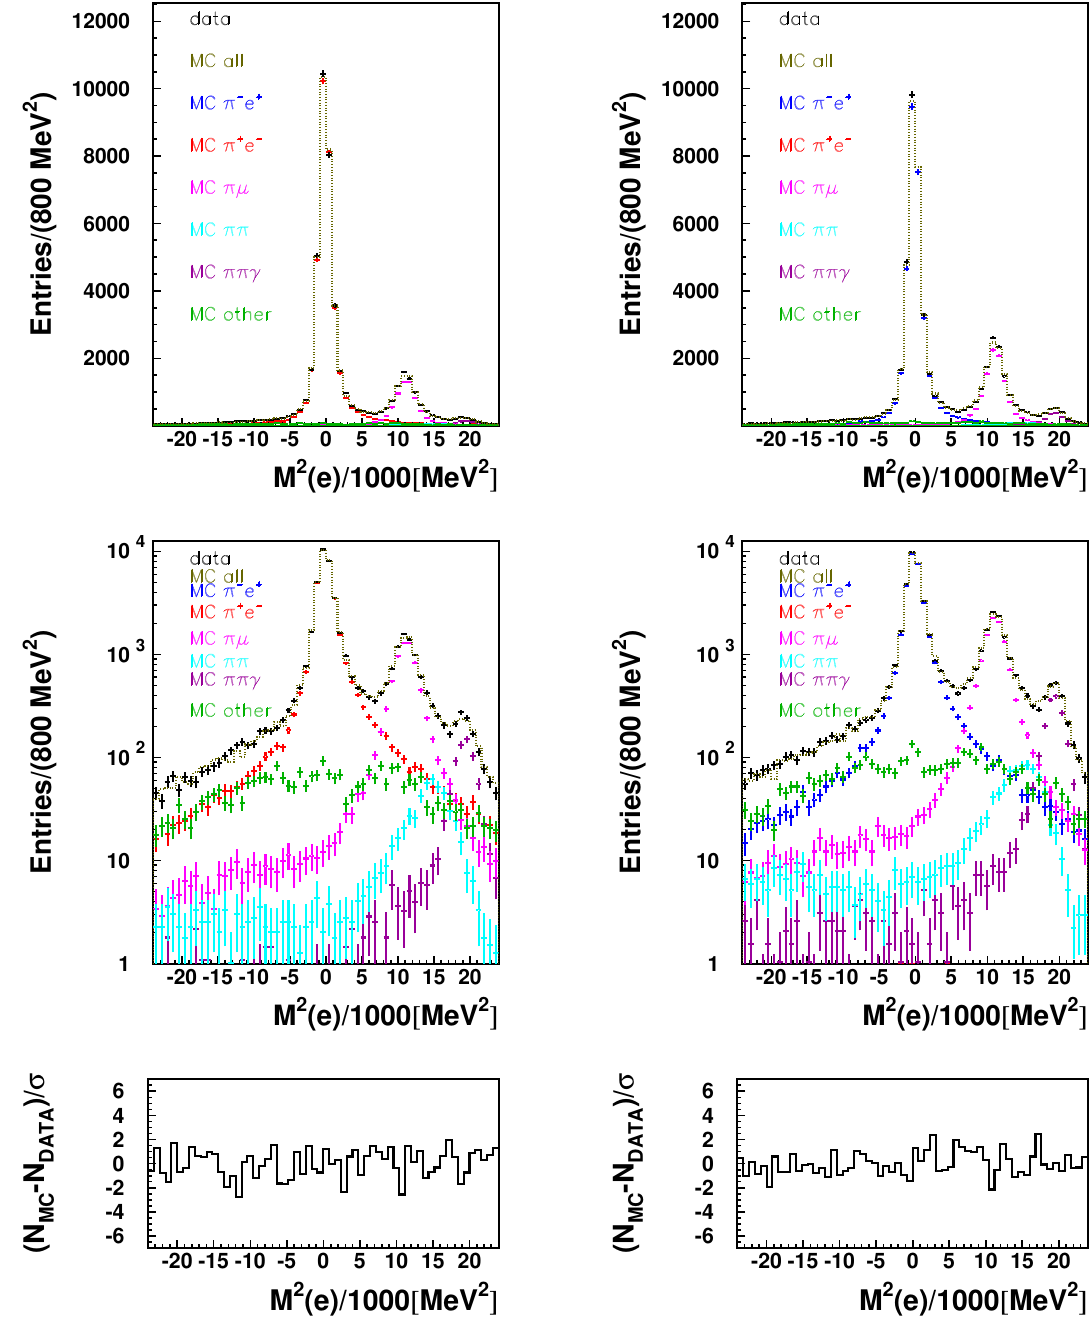
Figure 4 . M 2 ( e ) distribution for data (black points) and MC simulation (dotted histogram) for both (cid:12)nal charge states ( (cid:25) + e (cid:0) | left side, (cid:25) (cid:0) e + | right side) after the (cid:12)t. The individual MC contributions are shown superimposed in the plots (colored points | see legend in the plots). Bottom row: corresponding data-MC residual distributions after the (cid:12)t.